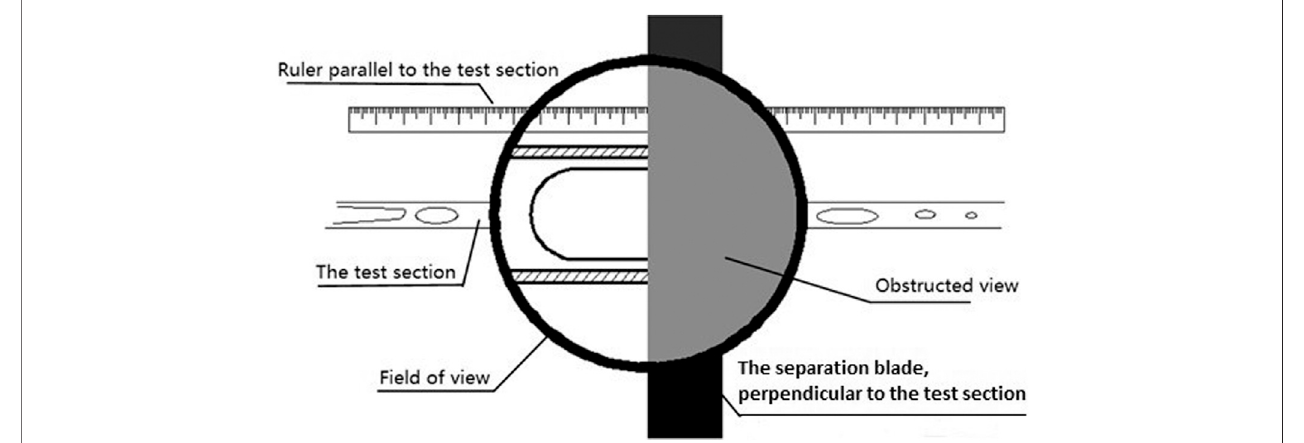
FIGURE 4 | Determination of the fl ow regime transition locations.